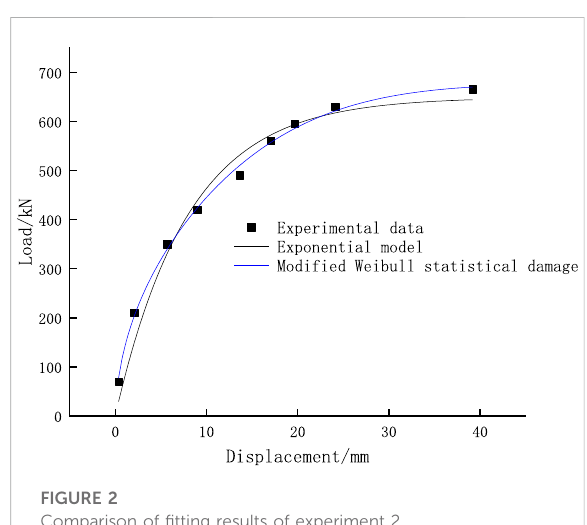
FIGURE 2 Comparison of fi tting results of experiment